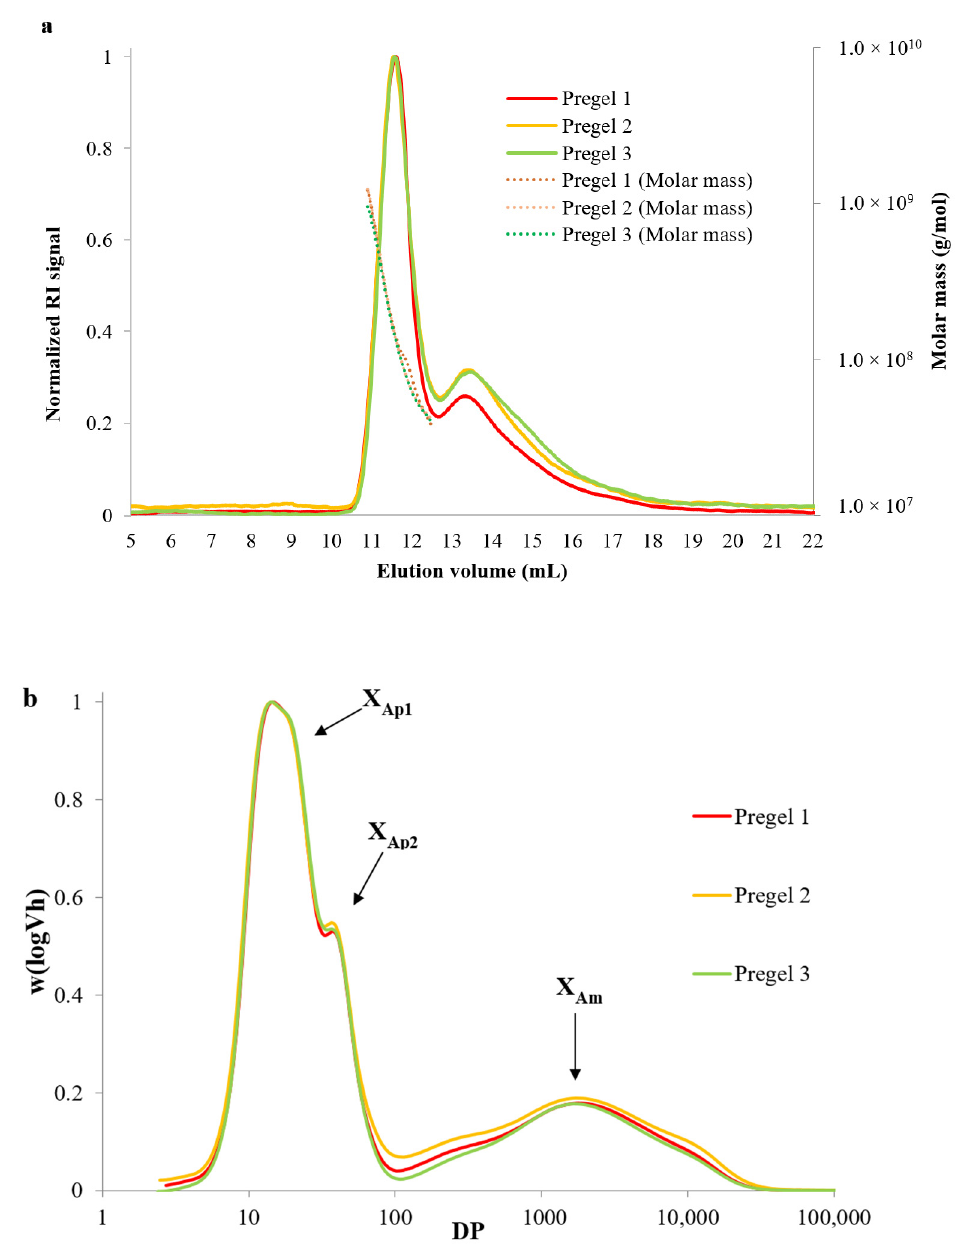
Figure 1. ( a ) Size exclusion chromatogram showing the normalized refractive index (RI) signal versus elution time for whole (branched) starch molecules, where two distinct peaks are observed corresponding to amylopectin (left) and amylose (right) molecules. The molar mass (g/mol) for amylopectin molecules is shown at the secondary axis. ( b ) Size exclusion chromatograms of de- branched starch showing the unit chain length distribution of wheat starch samples. DP indicates degree of polymerization.